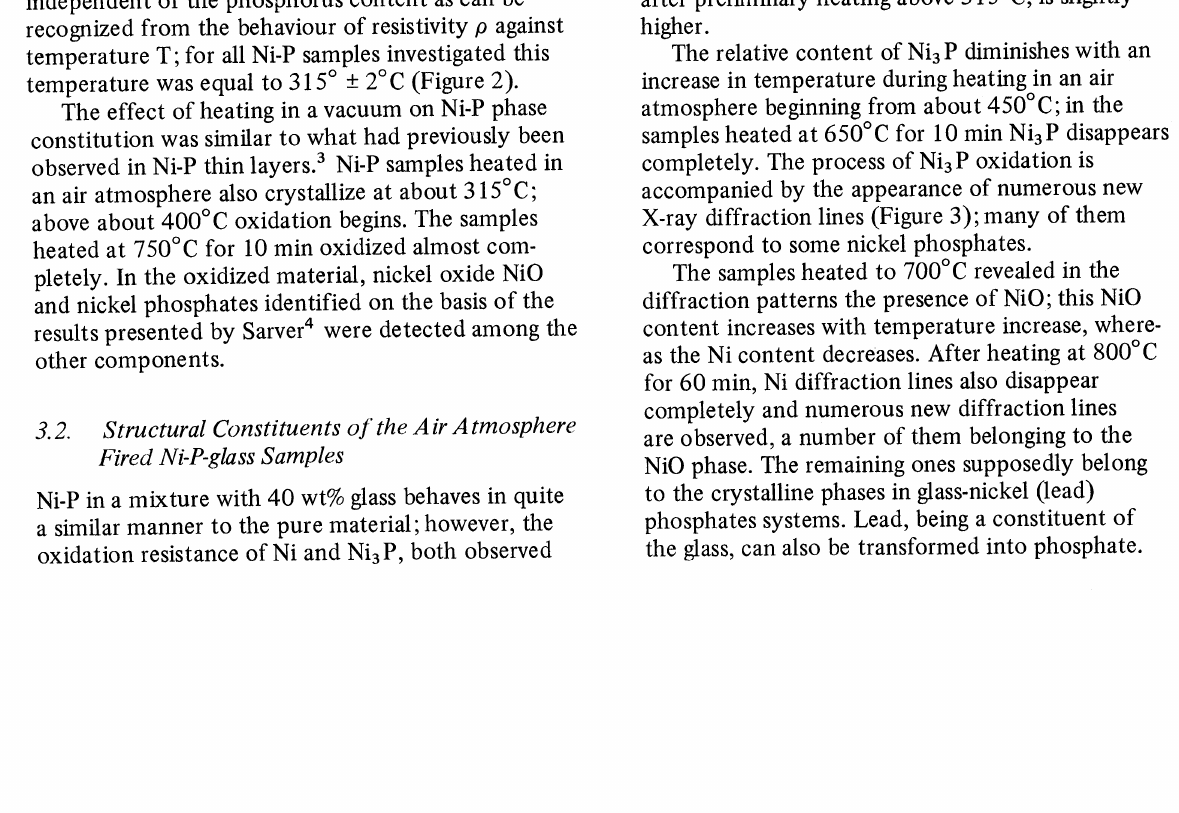
Diffraction patterns of Ni-P-glass system samples (9 wt% P in Ni-P) heated in an air atmosphere for 10